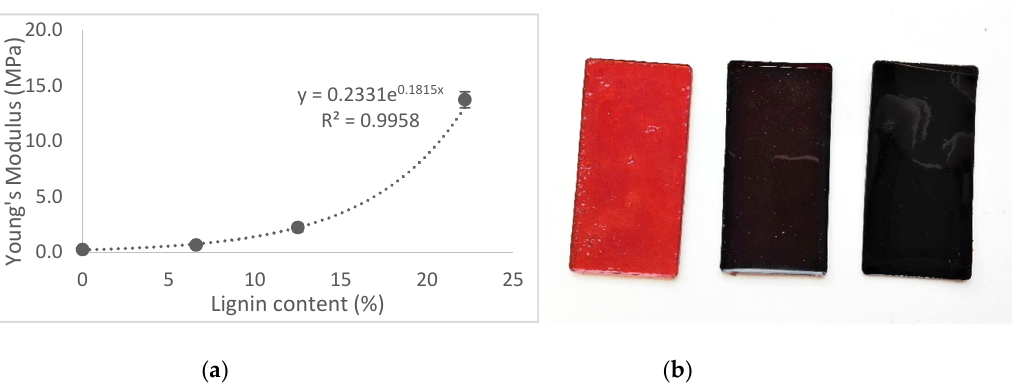
Figure 2. ( a ) Correlation between the lignin content and Young’s modulus of the cured epoxy resins. ( b ) Physical appearance of epoxy resins with 0%, 12.5%, and 22.2% weight of KL MeOH . Table 2. The effect of the diamine content on the thermomechanical properties of the epoxy resins. Diamine Equiv. to ELO me.